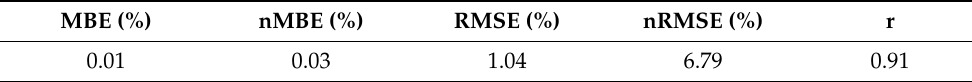
Table 8. Validation results of the soiling losses estimation with